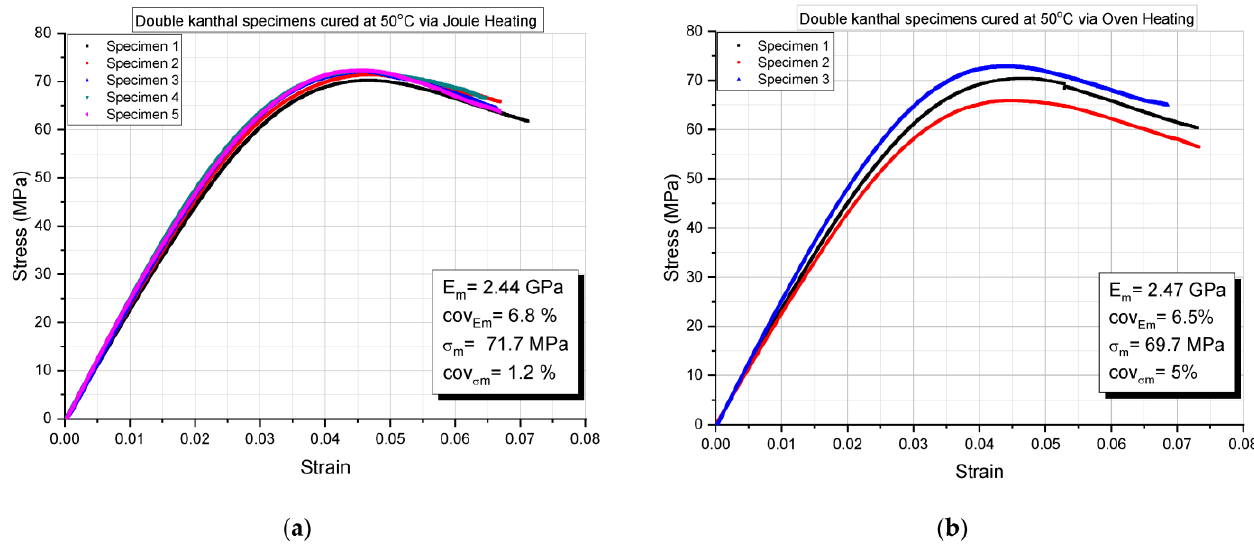
Figure 1. Quasistatic three-point bending results for double Kanthal fiber specimens cured at 50 °C using ( a ) Joule heating and ( b ) oven heating.